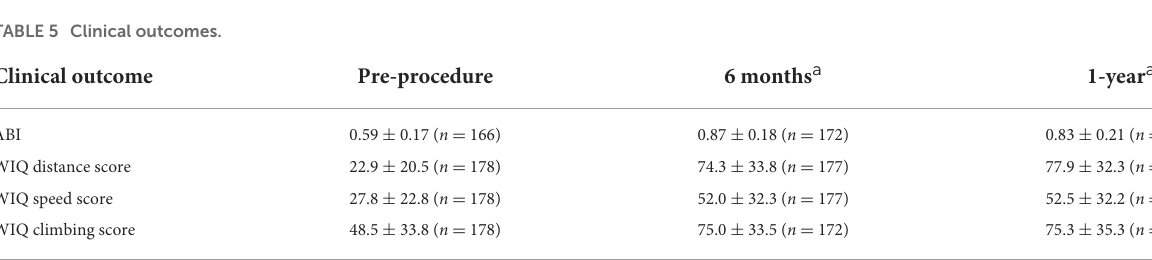
TABLE 5 Clinical